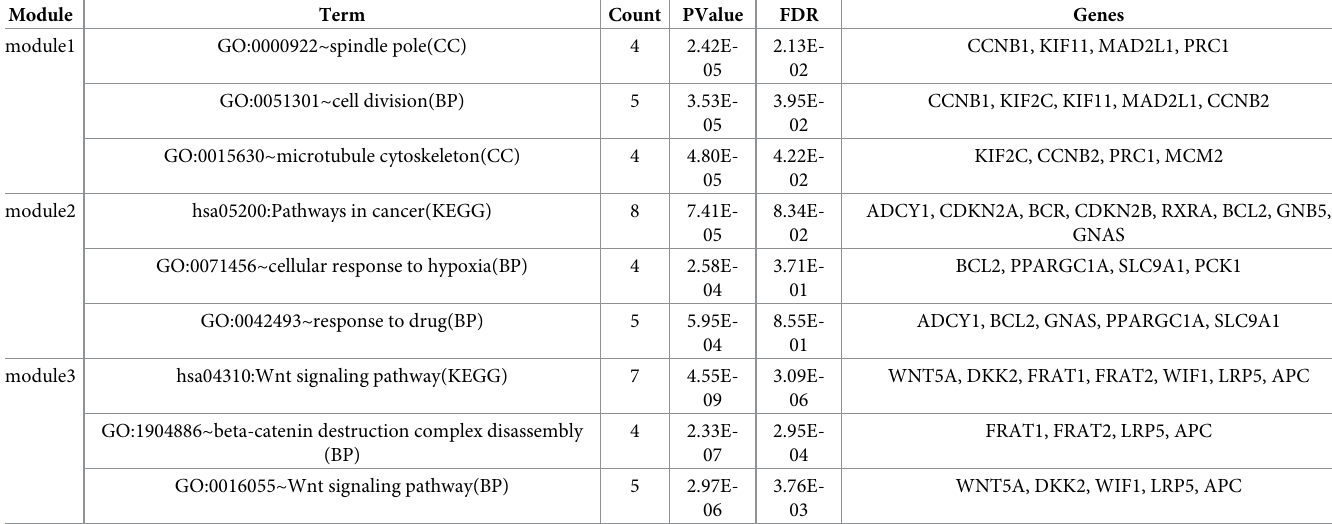
Table 3. The functional annotation and enrichment of modules